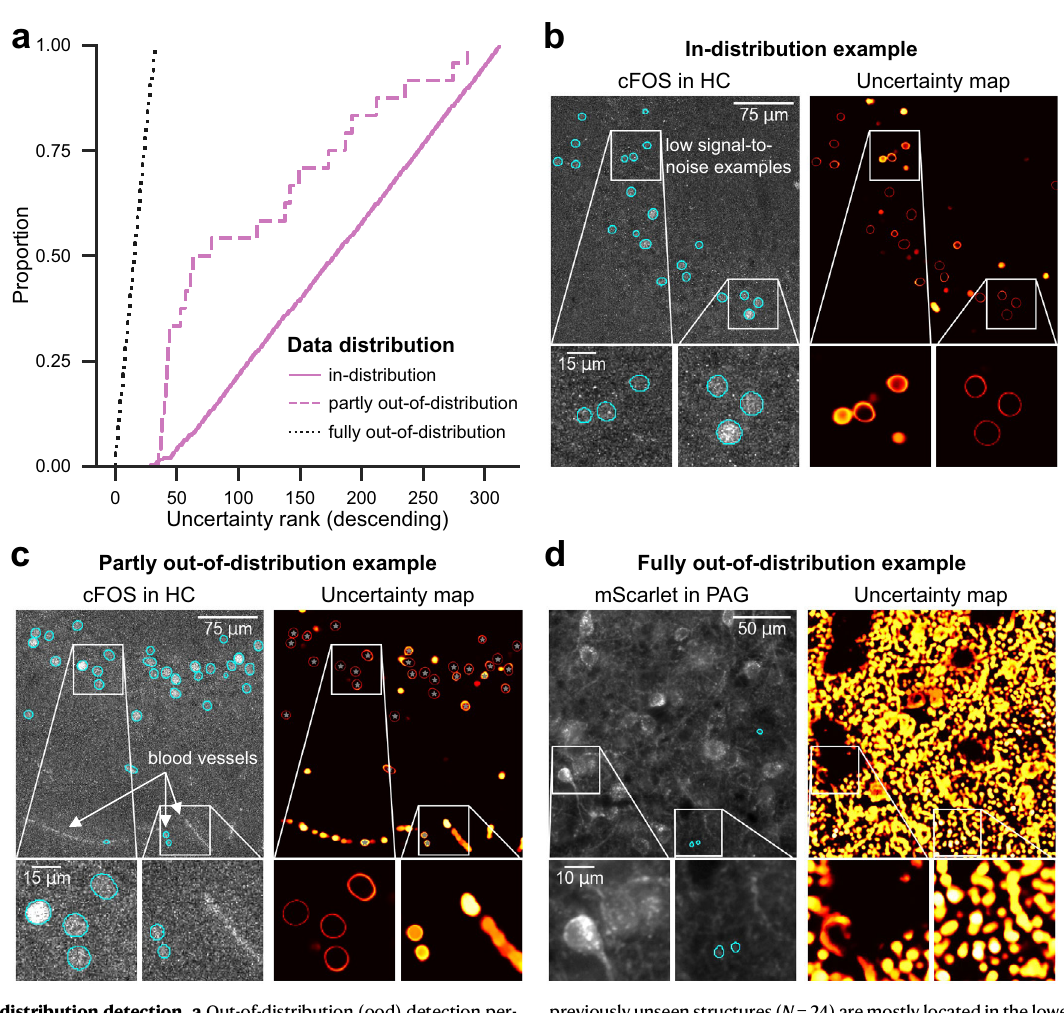
previouslyunseenstructures( N =24)aremostlylocatedinthelowerranks,andthe in-distribution images (similar to training data of cFOS in HC, N =264) are in the upper ranks. b – d Representative image crops of the three categories used in ( a ). Source data are provided as a Source Data fi